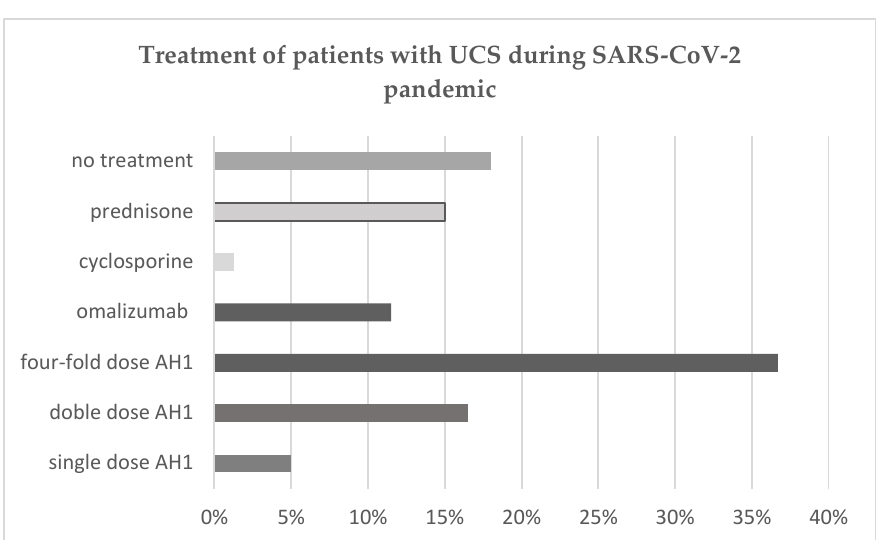
Figure 1. Treatment in patients with CSU during SARS-CoV-2 pandemic, represented as percent.